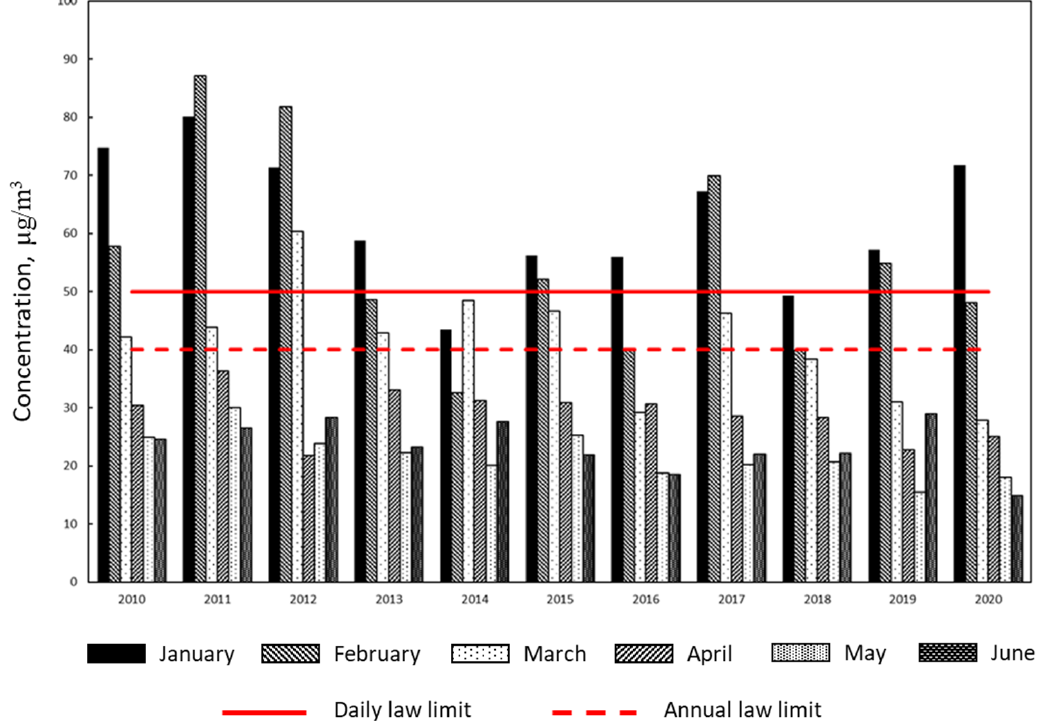
Figure 7. PM10 average monthly concentration in the first six months of the year in the period 2010–2020, measured in Milan by ARPALombardia, without considering the contribution of Saharan dust in March 2020; daily law limit for PM10 according to Lgs. 155/2010 (red solid line) and annual law limit for PM10 according to Lgs. 155/2010 (red dashed line).